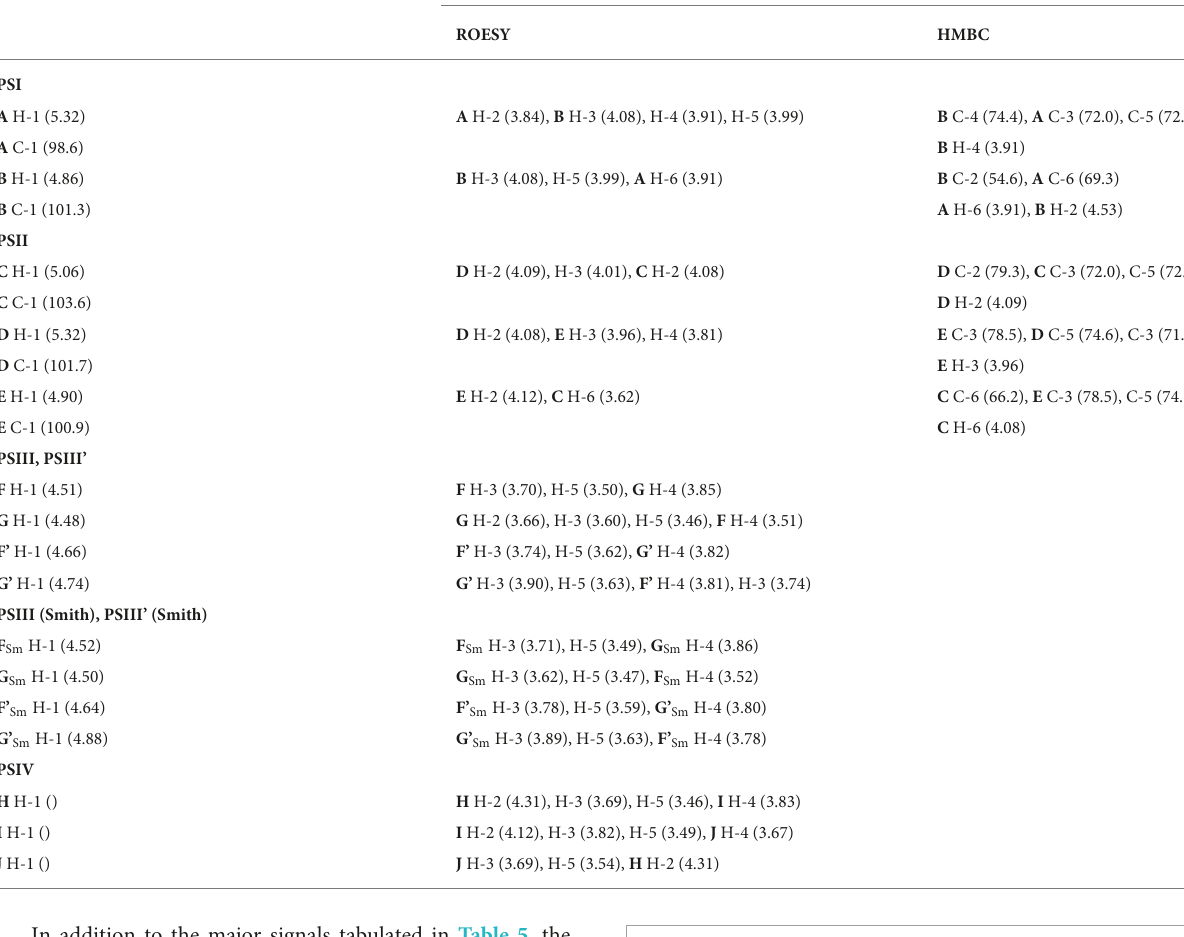
TABLE 6 Correlations for H-1 and C-1 in the 2D ROESY and 1 H, 13 C HMBC spectra of the 24 h (control) matrix polysaccharides of M. luteus C01. Anomeric atom in sugar residue ( δ ) Correlation(s) to atoms in sugar residue(s) ( δ ) ROESY